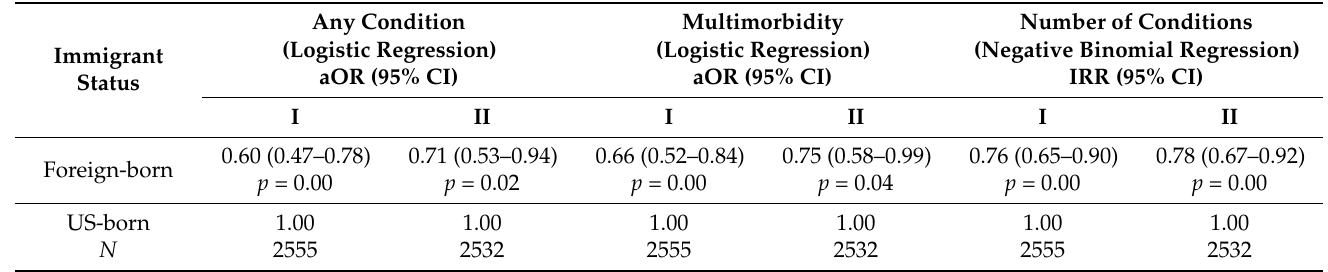
Table 2. Associations between immigrant status and health conditions.